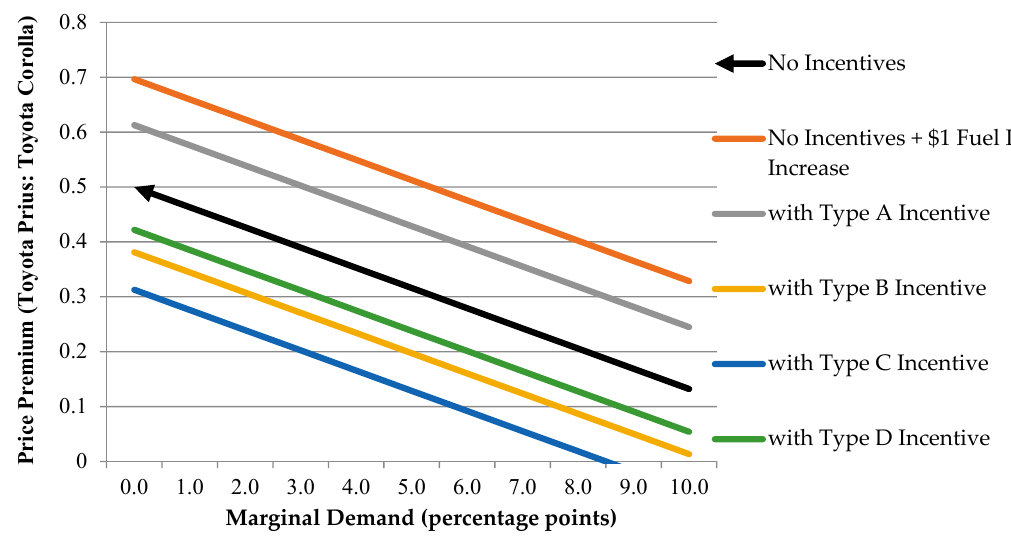
Figure 2. Price Premium as a function of Marginal Demand for various scenarios .